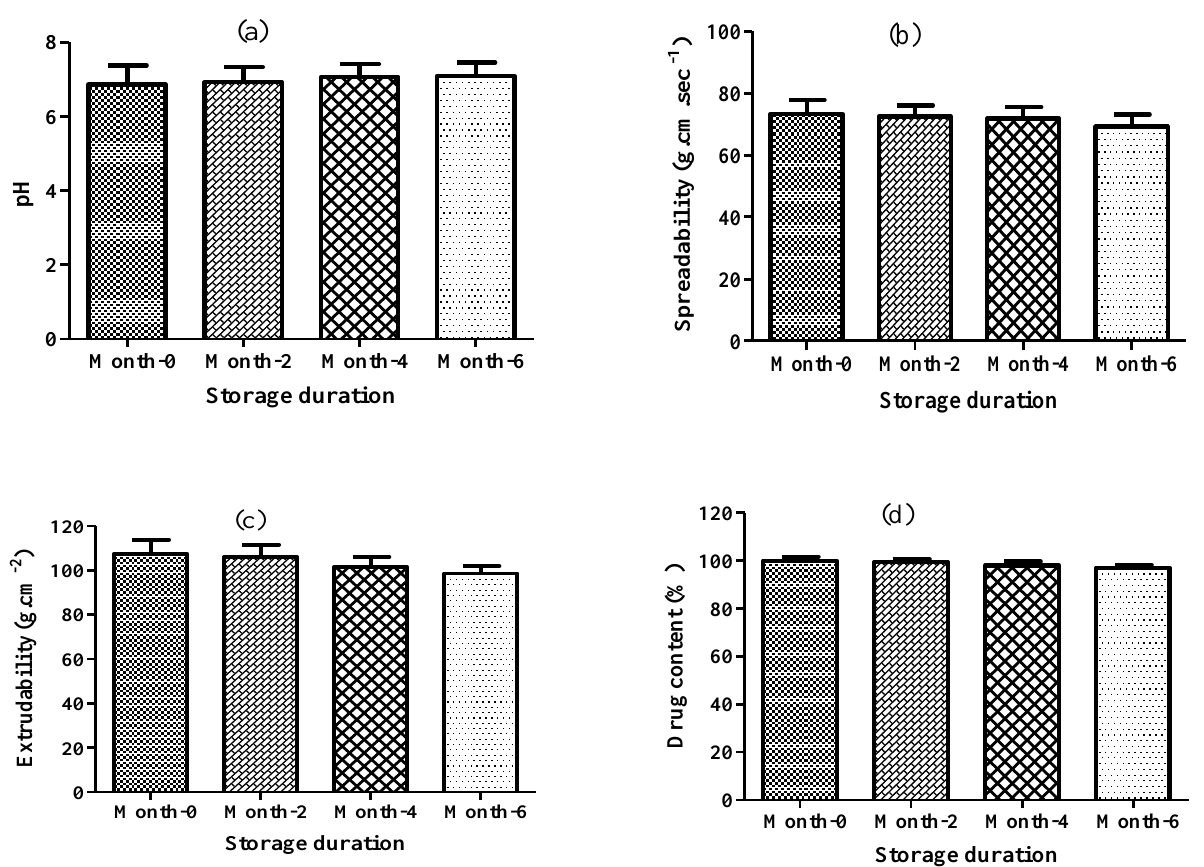
Figure 6. Stability studies ( a ) pH, ( b ) spreadability, ( c ) extrudability and ( d ) drug